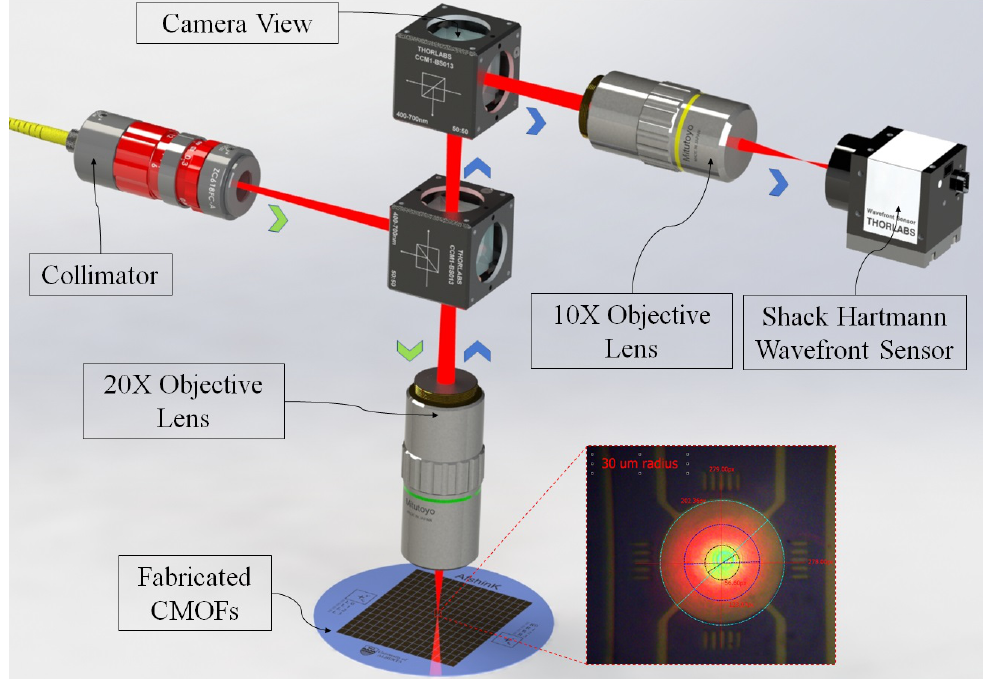
Figure 12. A 3D drawing of the optical setup for testing the CMOFs. The camera-taken picture of the focused laser on a CMOF shows a 16 µ m laser spot on a 30 µ m-radius